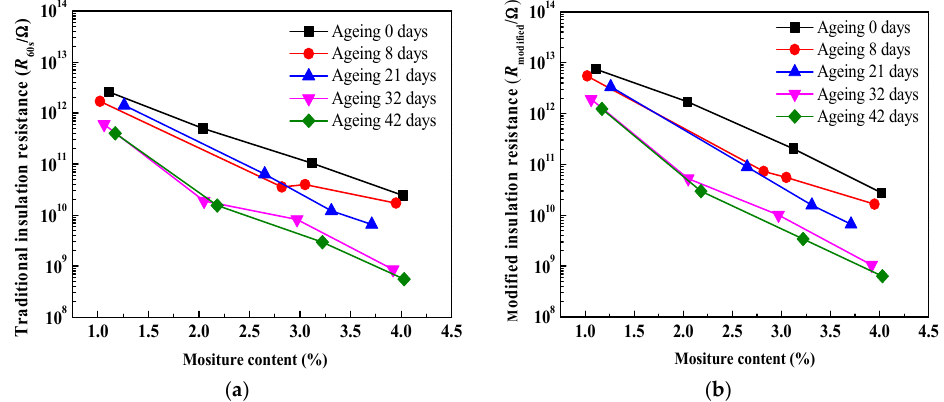
Figure 12. Comparisons of relationships between insulation resistances and moisture content. ( a ) Traditional insulation resistance; ( b ) modified insulation resistance.